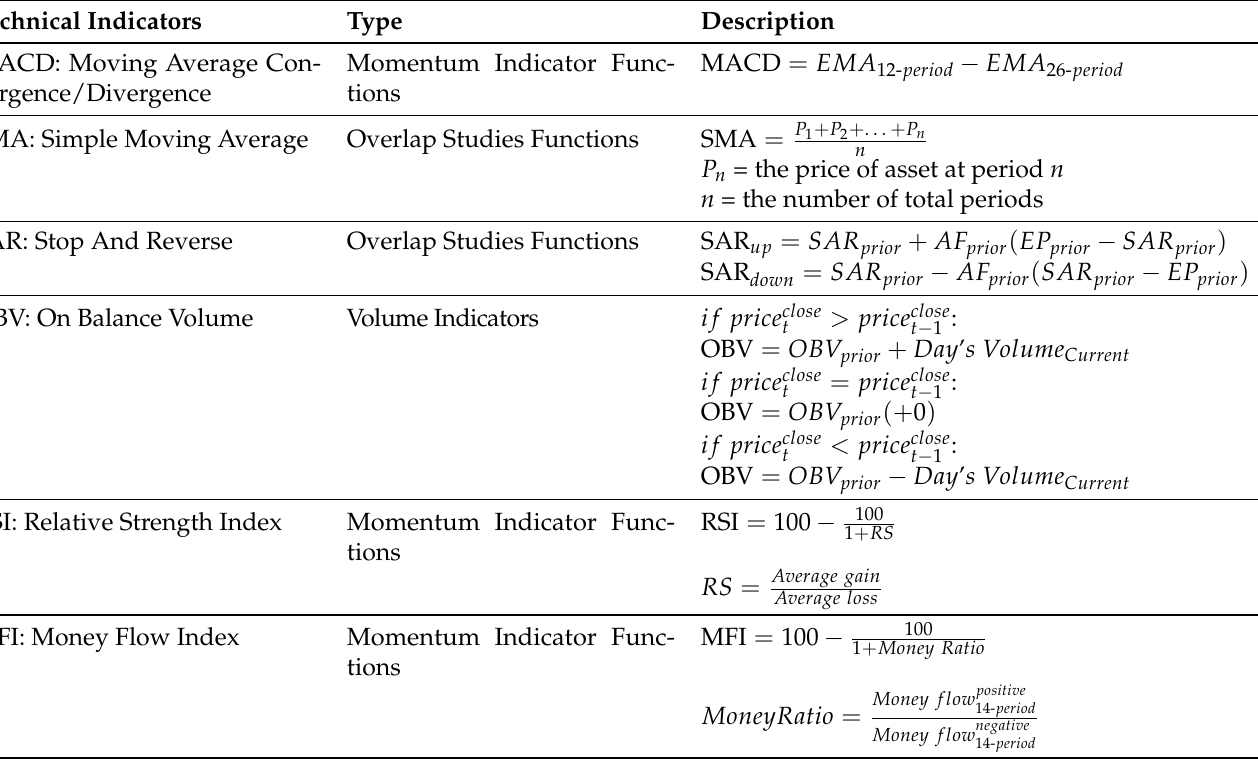
Table 1. Technical